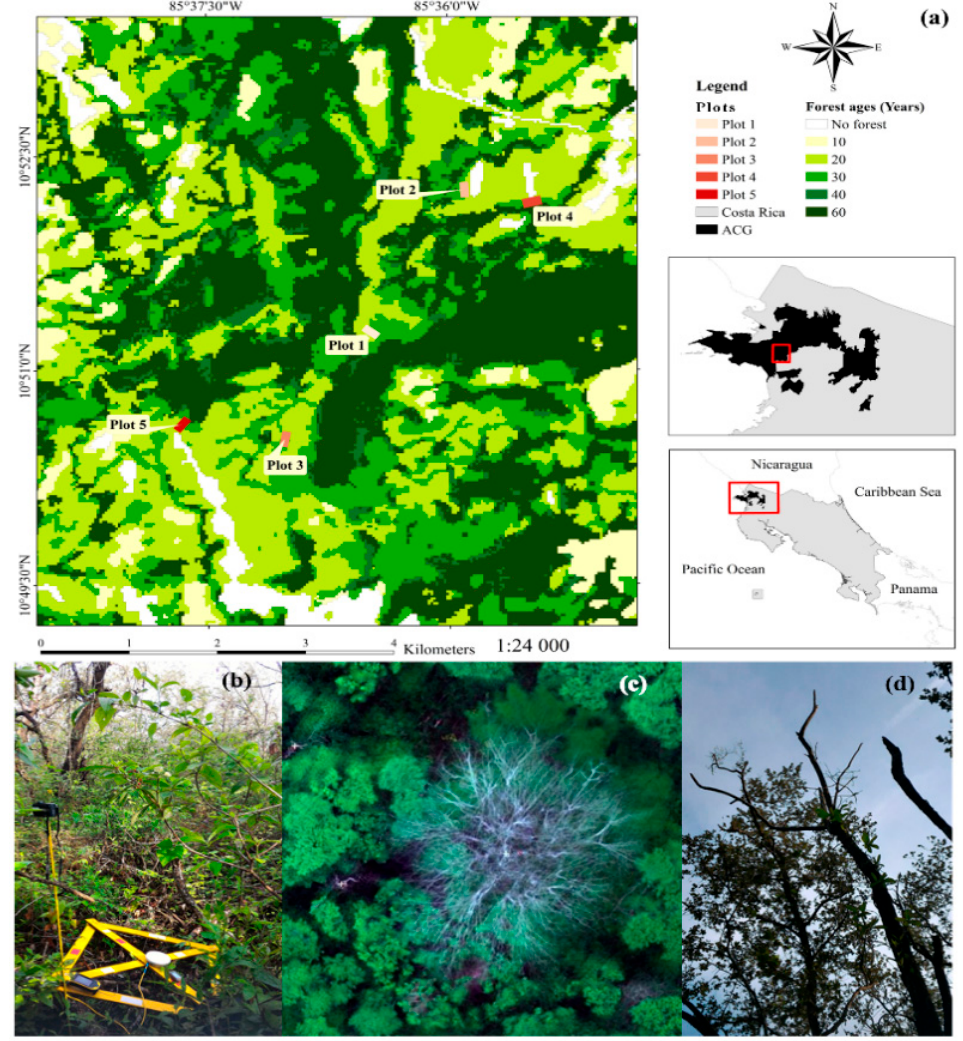
Figure 1. ( a ) Location map of the SR-EMSS; ( b ) ground reference points and GPS; ( c ) dead stand tree from UAV R: band red, G: band green, B: band blue; ( d ); dead stand tree viewed from ground.